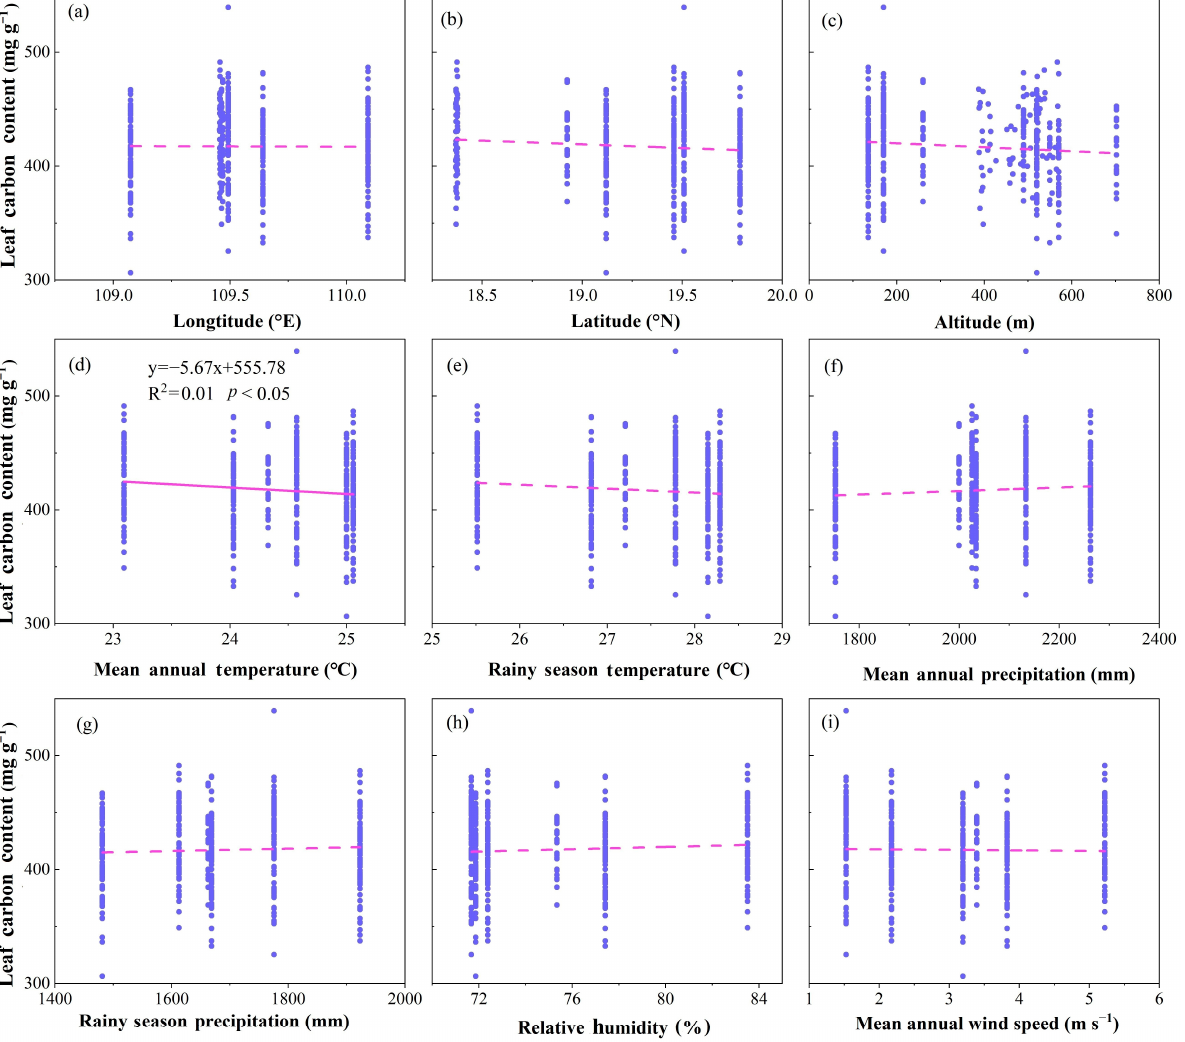
Figure 2. Changes in leaf carbon content (LCC, mg g − 1 ) with geographical and climatic factors in all samples. ( a ) LCC vs. longitude; ( b ) LCC vs. latitude; ( c ) LCC vs. altitude; ( d ) LCC vs. mean annual temperature; ( e ) LCC vs. rainy season temperature; ( f ) LCC vs. mean annual precipitation; ( g ) LCC vs. rainy season precipitation; ( h ) LCC vs. relative humidity; ( i ) LCC vs. mean annual wind speed. The scatter points in the figure represent the measured C content of plant leaves. The dotted line indicates no significant correlation between LCC content and geographical and climatic factors ( p > 0.05). The solid line indicates that the correlation between LCC content and climatic factors is significant ( p < 0.05).